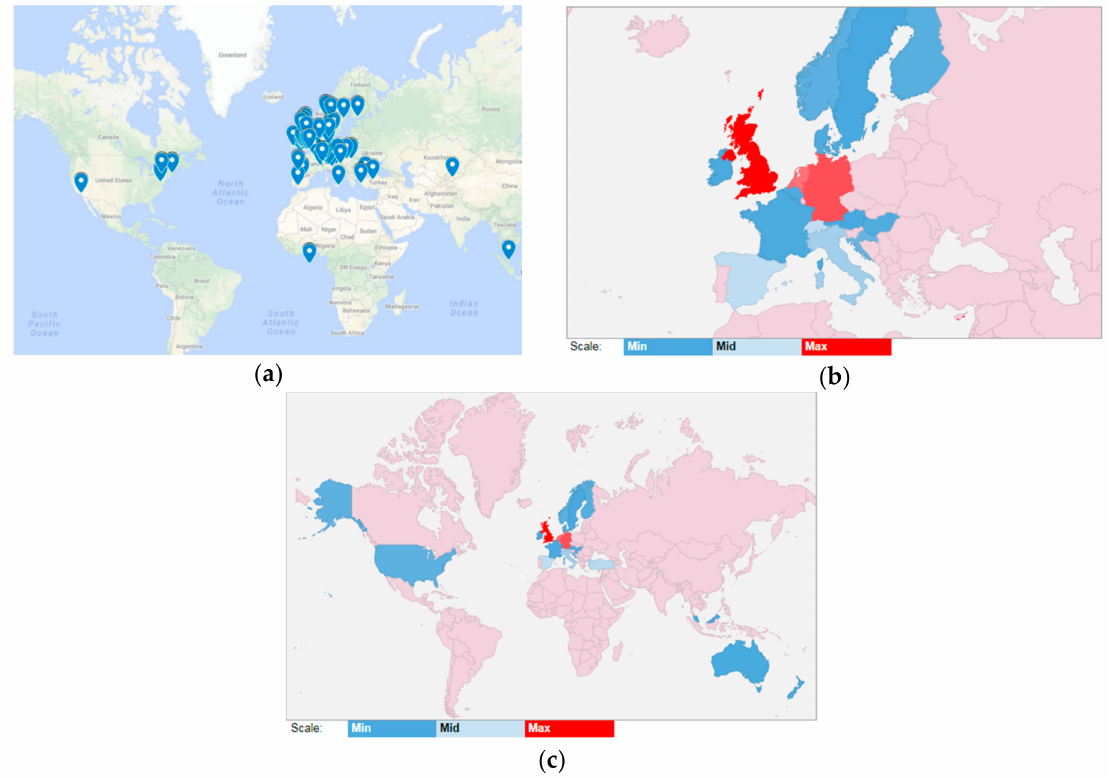
Figure 2. The geolocation data for Brunel publications found within CORE ( a ) Brunel publications by repository host locations (latitude and longitude coordinates); ( b ) Brunel publications by repository host locations in Europe (country code); ( c ) Brunel publications by repository host locations globally (country